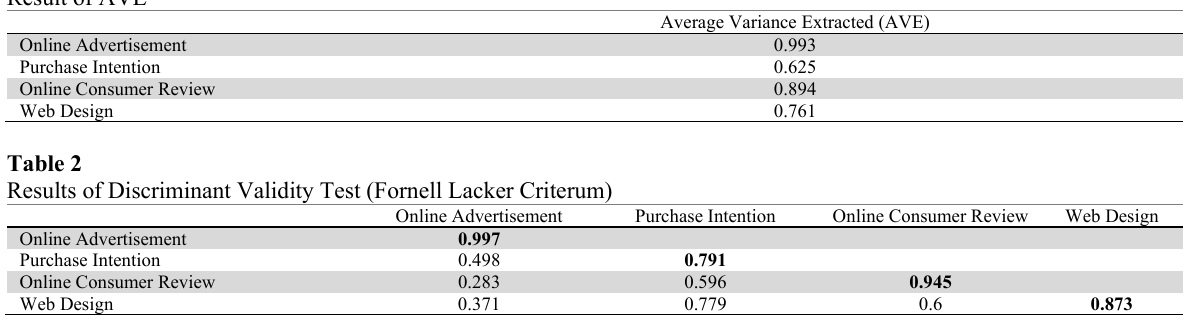
Result of AVE Online Advertisement